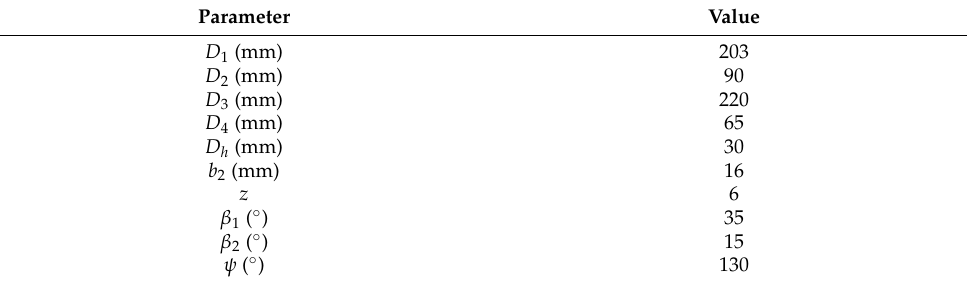
Figure 3. 2D hydraulic drawing of hydraulic turbine. Table 1. Main geometric parameters of the turbine.